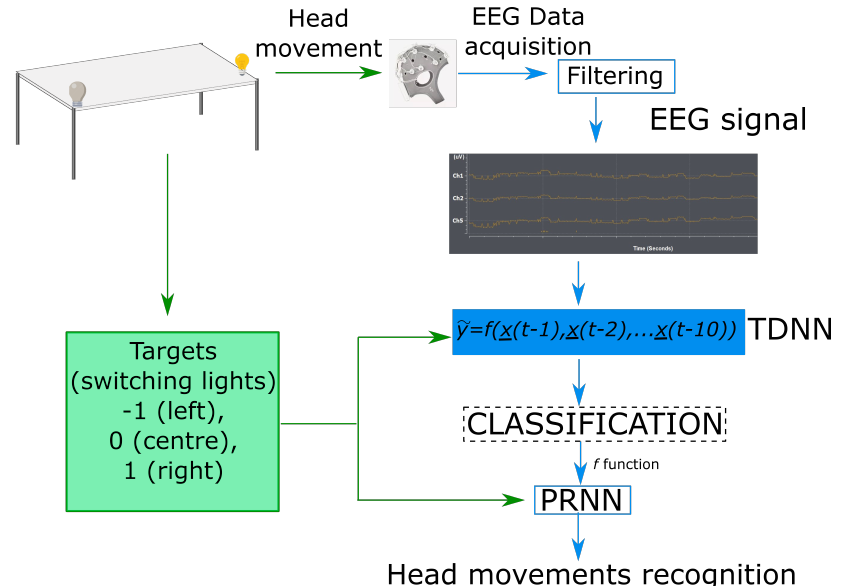
Figure 4. Architecture of the proposed